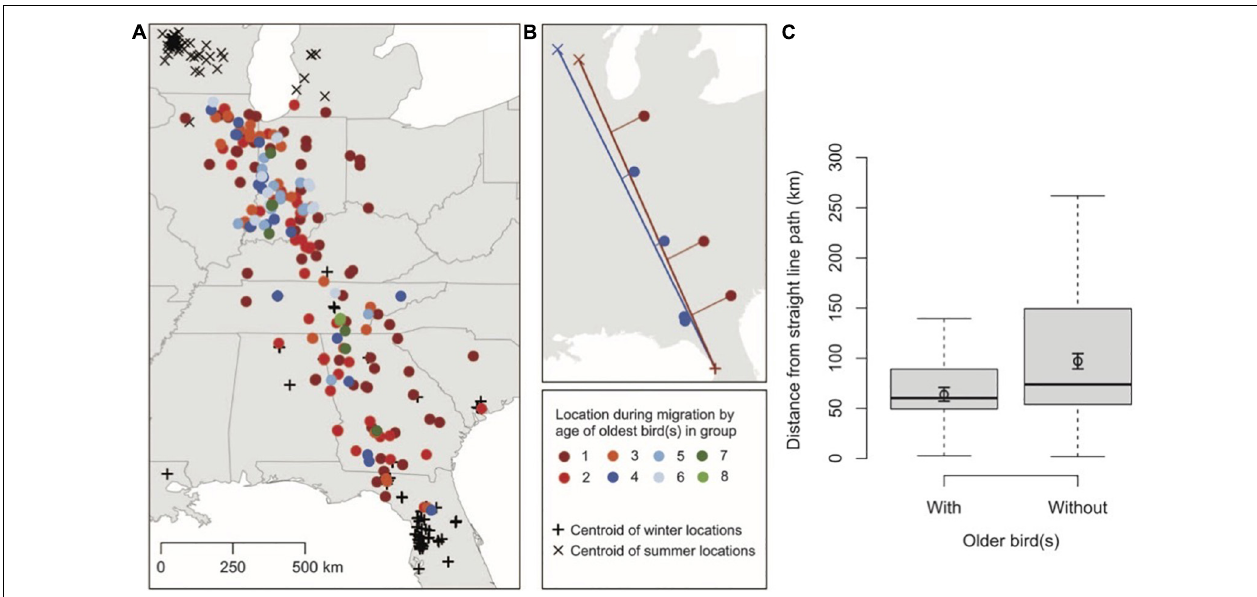
FIGURE 10 | Groups of whooping cranes containing old individuals migrate using more direct paths compared to groups consisting of only juveniles. (A) Telemetry and visually observed locations of whooping cranes throughout their migratory journey. (B) Examples of migratory routes that juveniles performed with (blue) and without (red) the presence of older individuals. (C) Distance from straight line paths during migration of juvenile groups with and without older individuals. Figure from Mueller et al. (2013) with